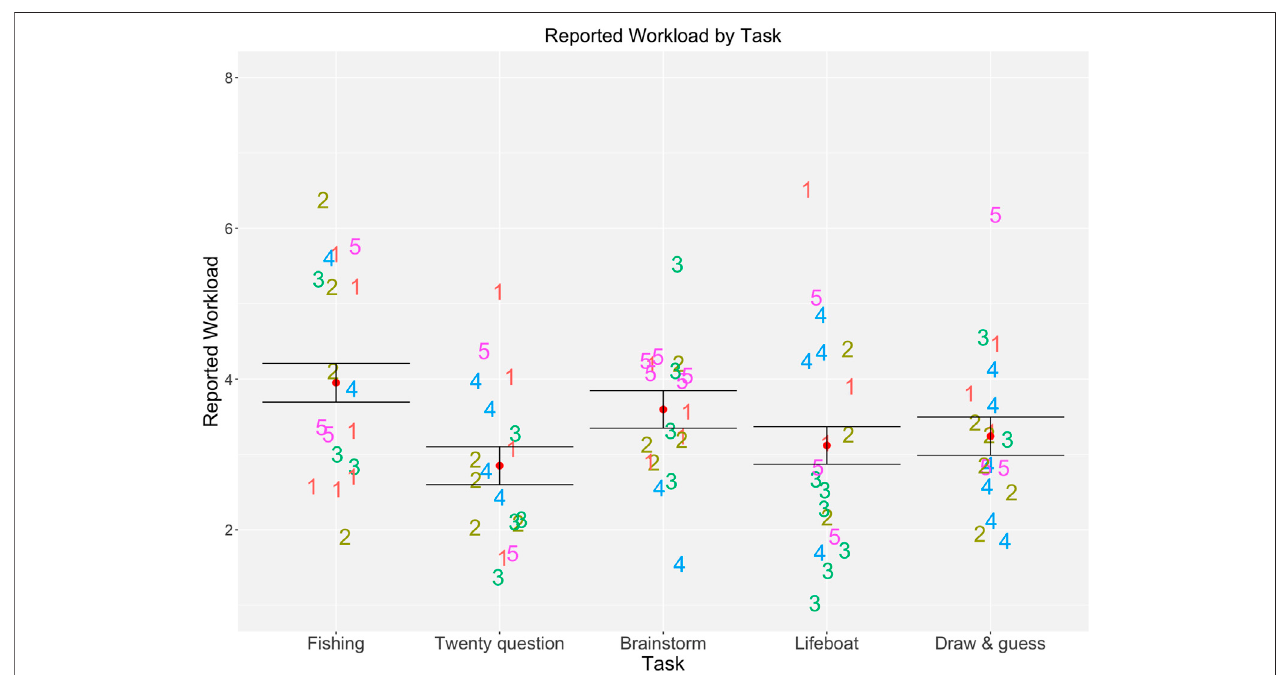
FIGURE 3 | Workload reported by participants for all sessions (1: low to 7:high). Red dots represent mean and black bars show standard error of the mean (SE). Numbers on the plot shows session number and the position of number is associated with the reported